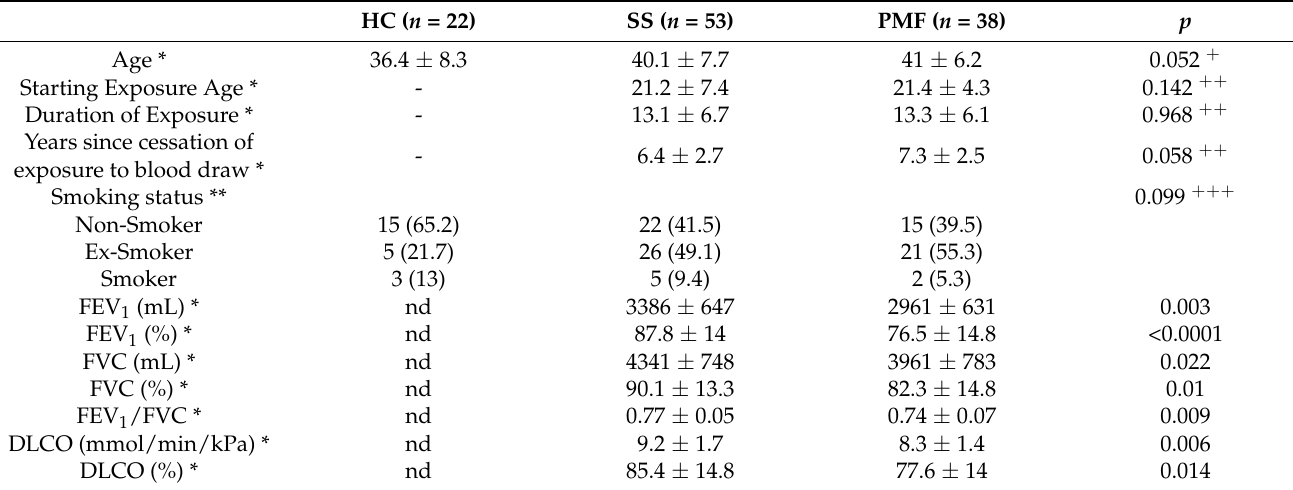
Table 1. Sociodemographic data of participants and pulmonary function values of patients with SS and